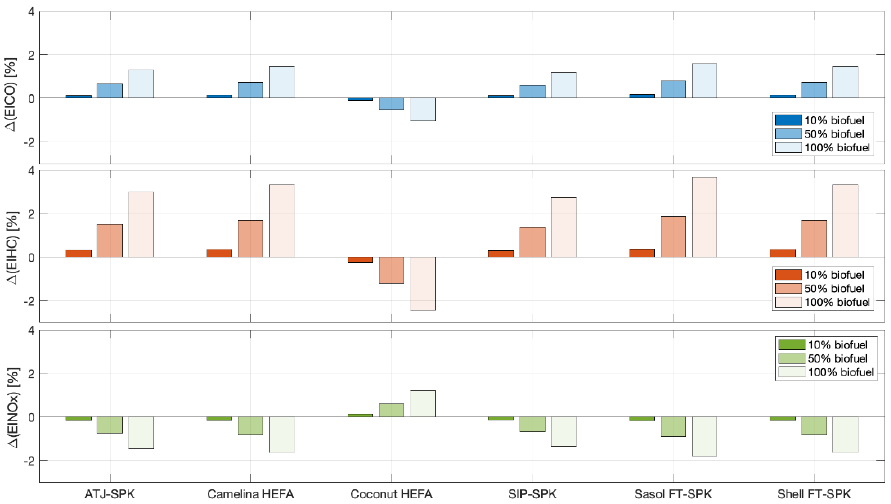
Figure 12. EI percentage variation due to different biofuel blending ratios.